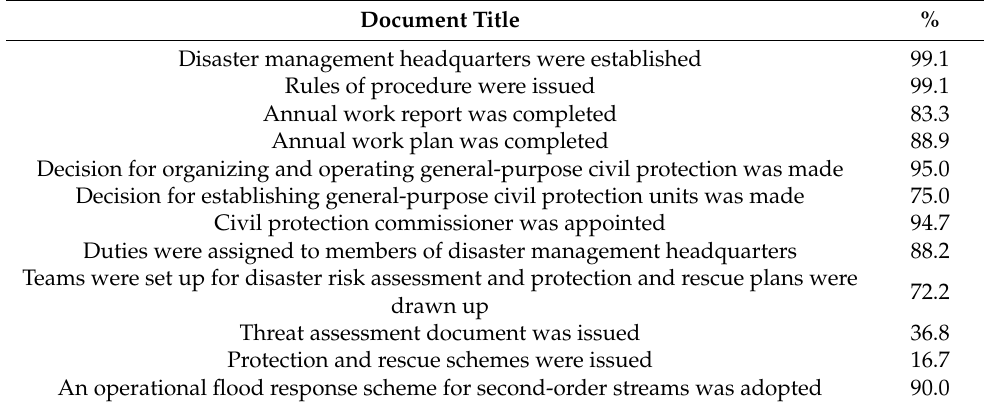
Table 5. Review of appropriate acts carried